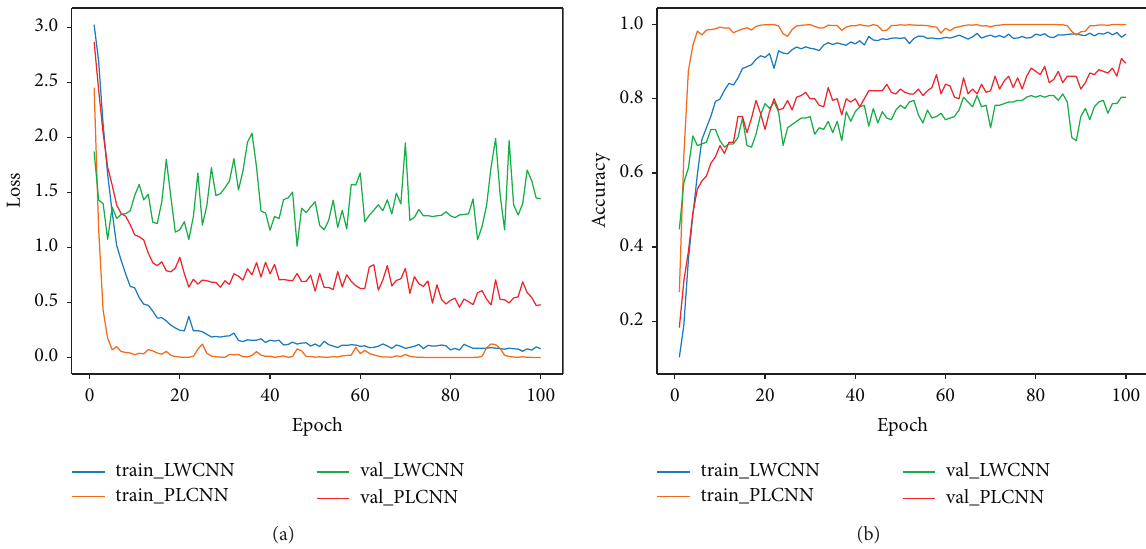
Figure 14: Loss function trend chart and precision change trend chart for Exercise C: (a) loss tend; (b) accuracy trend.